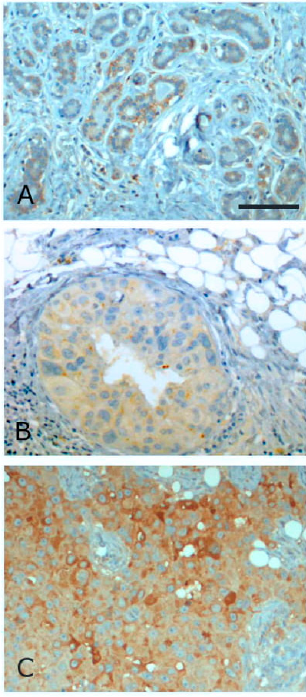
Figure 4. Immunoperoxidase staining for syndecan-1 in breast tissues. ( A )—benign hyperplasia, ( B )—ductal carcinoma in situ, ( C )—infiltrating ductal carcinoma. In these carcinomas, there is loss of membrane staining but acquisition of general cytoplasmic staining. Scale bar = 100 µm.